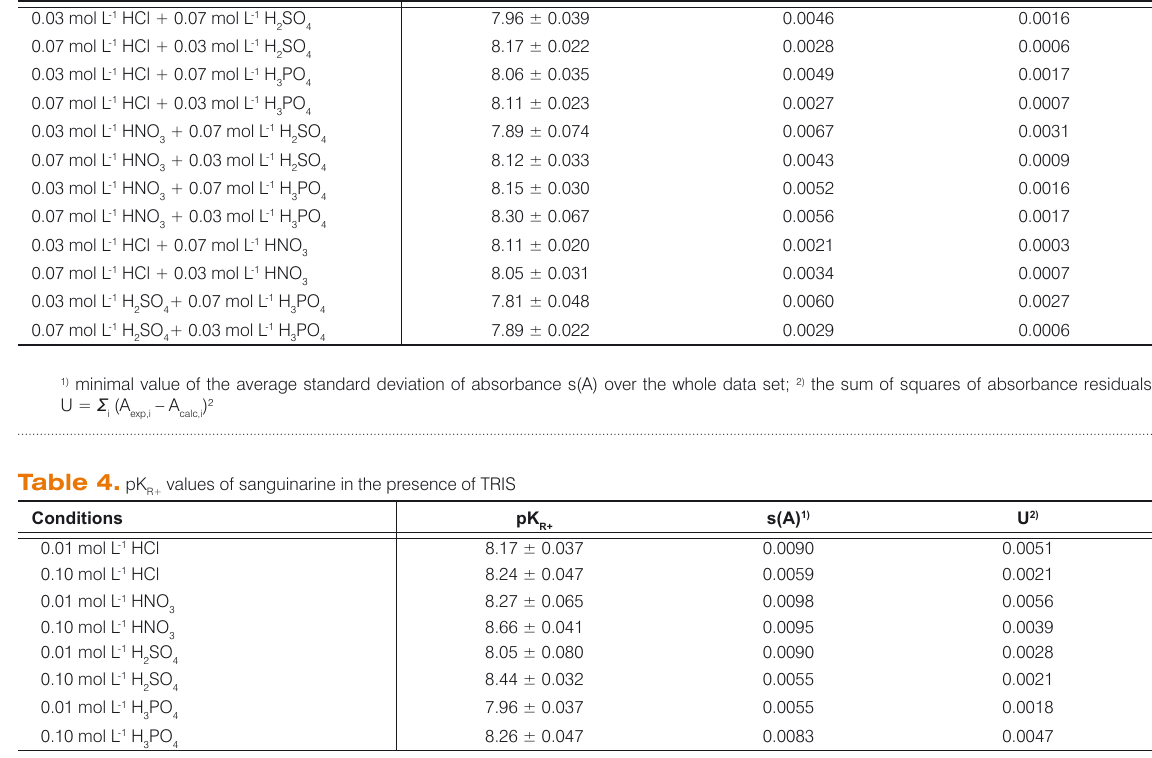
Table 3. pK values of sanguinarine in mixtures of inorganic acids (c = 0.1 mol L -1 , concentrations ratios 0.03 + 0.07 mol L -1 and 0.07 + 0.03 mol L -1 , R+ respectively)) Conditions